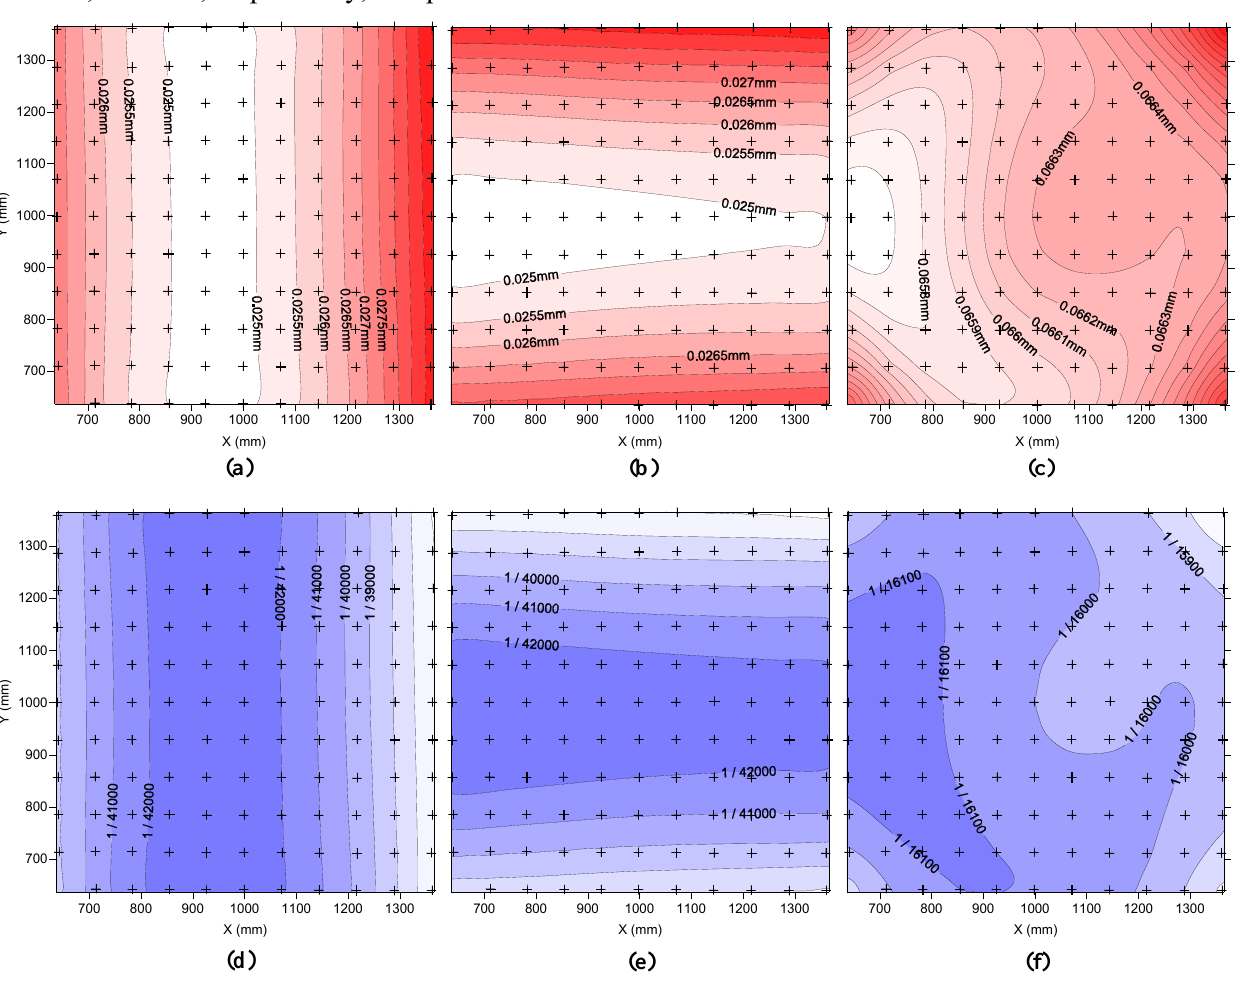
Figure 5. Spatial distribution of standard deviation (mm) obtained in the field test in the directions of X (a), Y (b) and Z (c). In (d), (e) and (f) standard deviation in the direction of X, Y and Z, respectively, is represented in relative